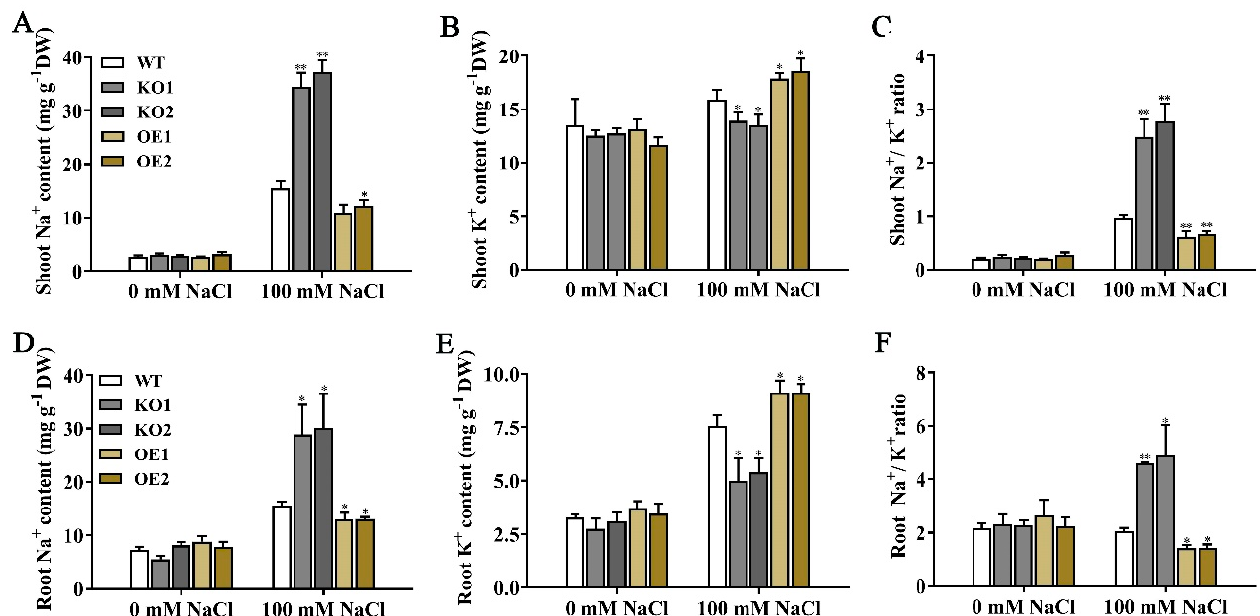
Figure 7. Effects of OsJRL40 on Na + and K + accumulation in rice seedlings under salt stress conditions. Fifteen–day–old seedlings were treated with a hydroponic medium containing 100 mM NaCl for 2 days. ( A , B ) Contents of Na + ( A ) and K + ( B ) in shoots. ( C ) Na + /K + ratio in shoots. ( D , E ) Contents of Na + ( D ) and K + ( E ) in roots. ( F ) Na + /K + ratio in roots. Data represent mean ± SD ( n = 3). Asterisks indicate statistically significant differences (Student’s t -test; * p < 0.05, ** p < 0.01). DW, dry weight.